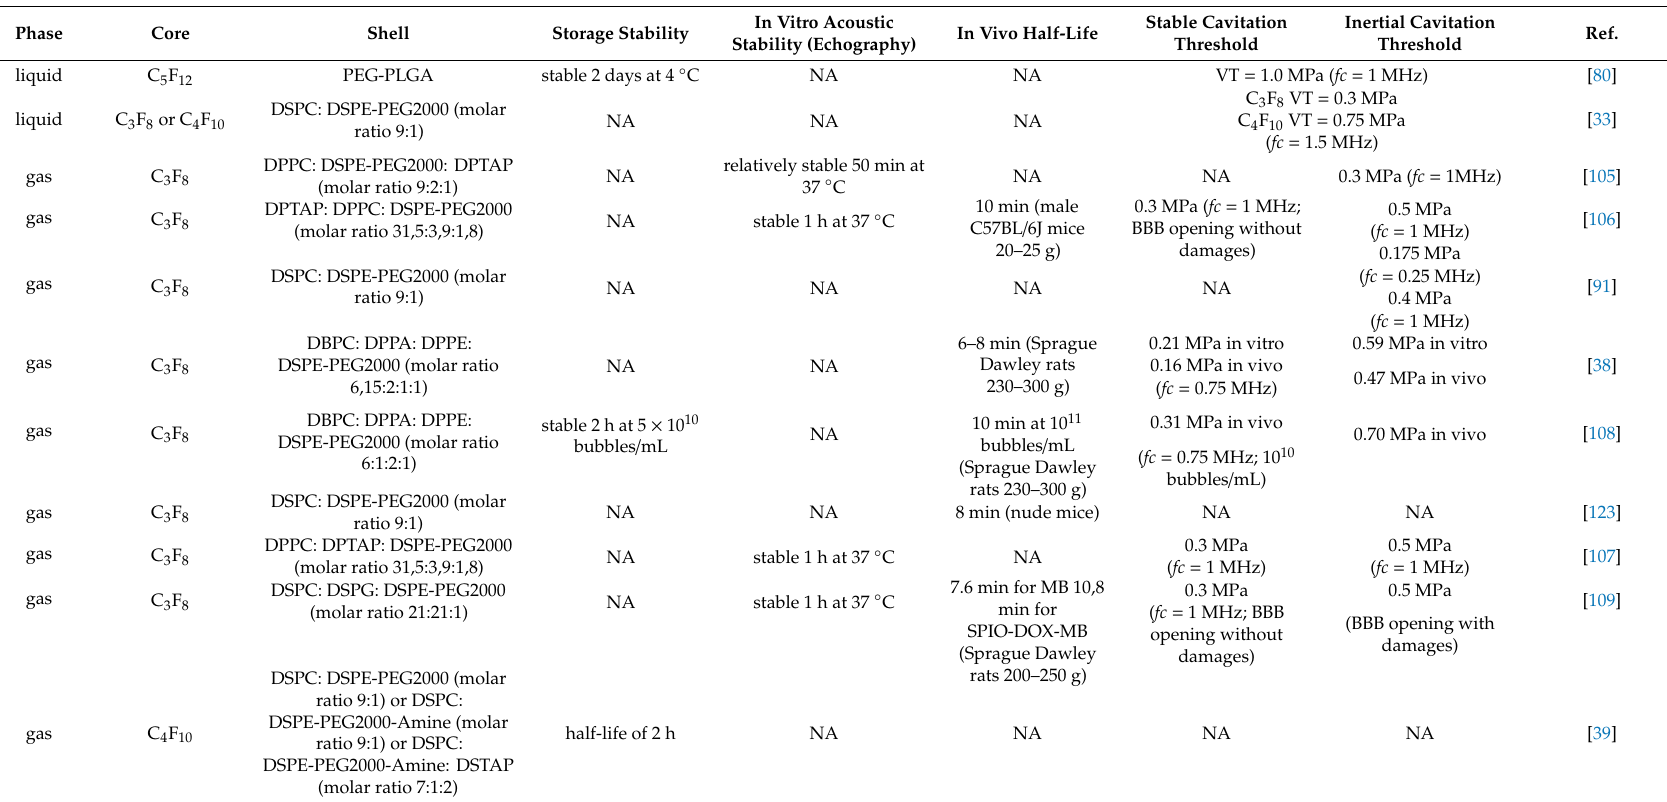
Table 3. Stability and cavitation thresholds assessment for sono-sensitive agents for BBB opening; without other specifications, cavitation thresholds are detected with in vitro passive cavitation detection. The storage stability was assessed by taking samples at several times after agent formulation and checking its echographic stability [80], cavitation emissions [108,125], concentration [39], or therapeutic e ff ect [102]. In Vitro Acoustic Stable Cavitation Inertial Cavitation Shell In Vivo Half-Life Stability (Echography) Threshold Threshold